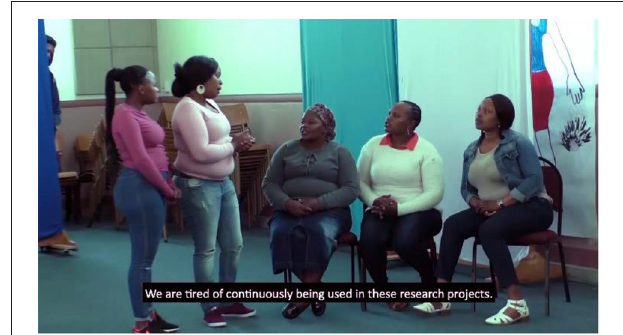
FIGURE 5 | A clip from the film “Doing it Differently”, showing a moment in a role play performed by members of the Enkanini focus group for the Water Resource Laboratory team at the knowledge exchange event in